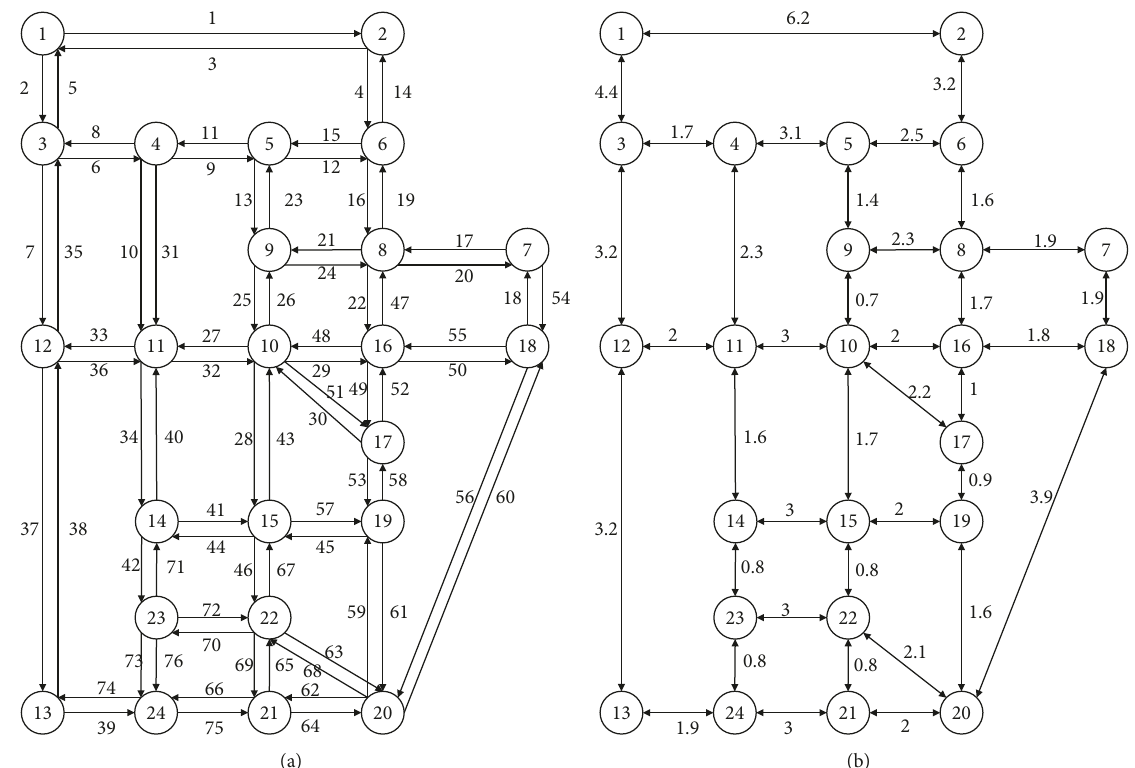
Figure 2: Sioux Falls in South Dakota with the adjusted distance network: (a) simple network topology; (b) network topology with distance.